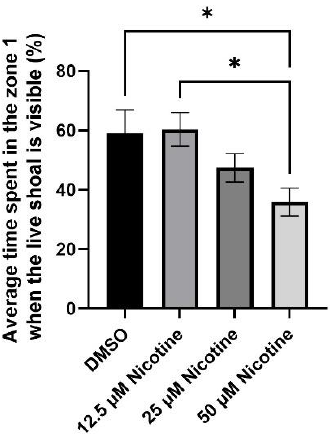
Figure 7. Embryonic exposure to 50 µM nicotine significantly reduces the time spent near a live shoal. Bars represent the average percentage of time spent in the zone closest to the live shoal while the live shoal was visible. * = p < 0.05.